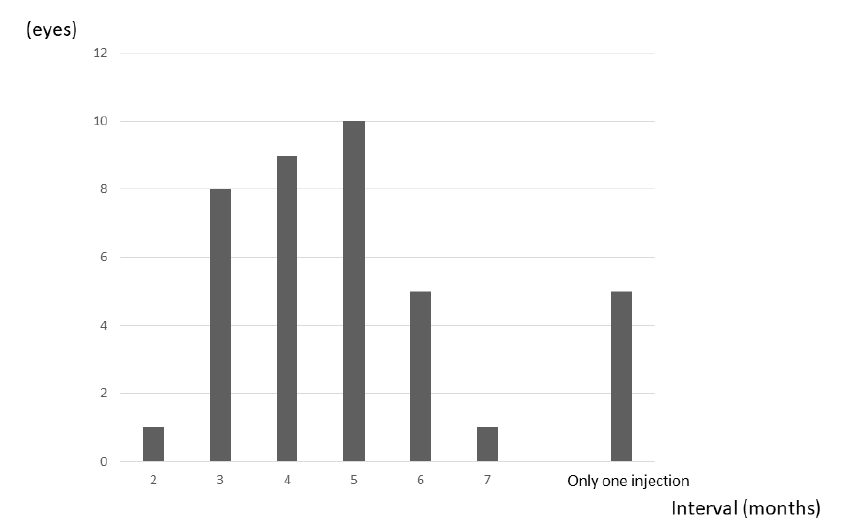
Figure 6. Frequency of maximum dosing interval. Five eyes (13%) had no recurrence. The IVA injection interval could be extended to more than 5 months in 21 eyes (54%) (including all 5 eyes showing no recurrence).